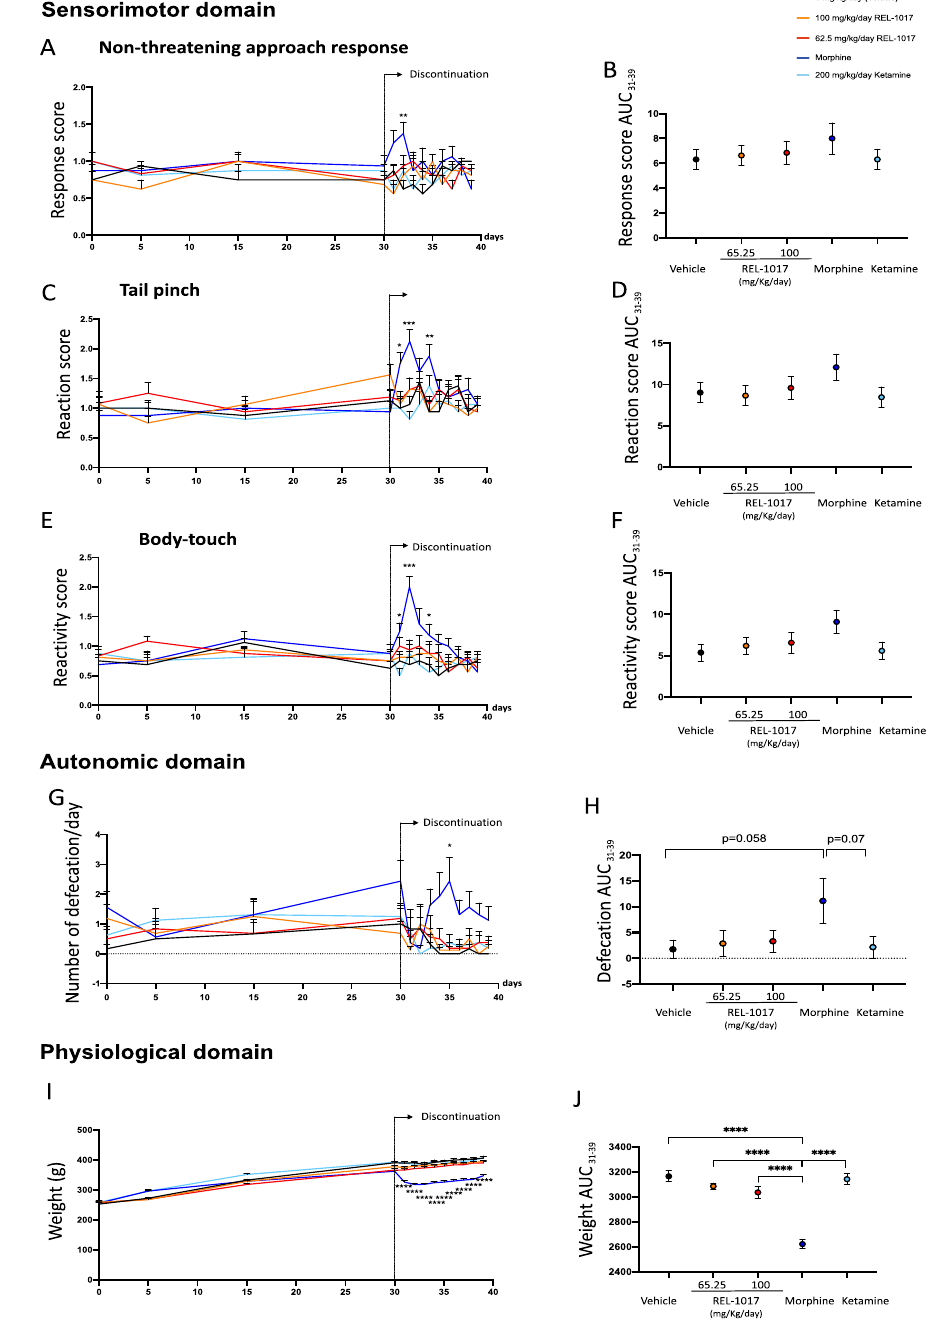
Figure 5. Discontinuation of chronic REL-1017 (esmethadone) administration did not cause modification in sensorimotor, autonomic and physiological measures. Following abrupt cessation after 30 consecutive days of drug administration, measures related to sensorimotor functions performed during the following 9 consecutive days, including non-threatening approach response ( A ), tail pinch ( C ), and simple body-touch ( E ) were significantly different in morphine-treated rats (dark blue line) compared to vehicle (black line) and REL-1017-treated rats (yellow and red lines *p < 0.05; **p < 0.01; ***p < 0.001; ****p < 0.0001). AUC values of non-threatening approach response ( B ), tail pinch ( D ), and simple body-touch ( F ) were measured over the time interval 31–39 days. No differences were observed between AUCs of morphine-treated rats (blue dot) to AUCs of vehicle (black dot) and REL-1017-treated rats (yellow and red dots). ( G ) Defecation (autonomic) and ( I ) body weight (physiological) measures obtained during the 9 days following abrupt cessation after 30 consecutive days of vehicle (black line) and REL-1017 (yellow and red lines) administration differed significantly from those obtained following abrupt cessation after 30 consecutive days of morphine (dark blue line; *p < 0.05 at day 5; ***p < 0.001, at day 1–9). The AUC value of defecation ( H ) measures over the time interval 31–39 days of morphine-treated rats (blue dot) showed a trend of increase compared to the AUC of vehicle (black dot, p = 0.058). The AUC value of body weight ( J ) measures over the time interval 31–39 days of morphine-treated rats (blue dot) were statistically decreased compared to the AUC of vehicle (black dot) and REL-1017-treated rats (yellow and red dots, ****p <